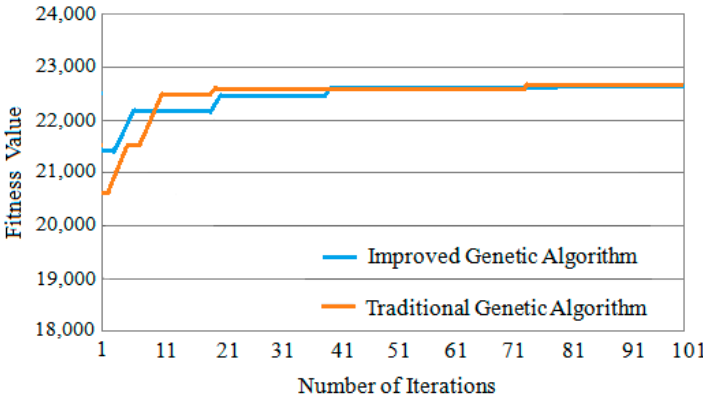
Figure 10. Convergence speed comparison of MWD.